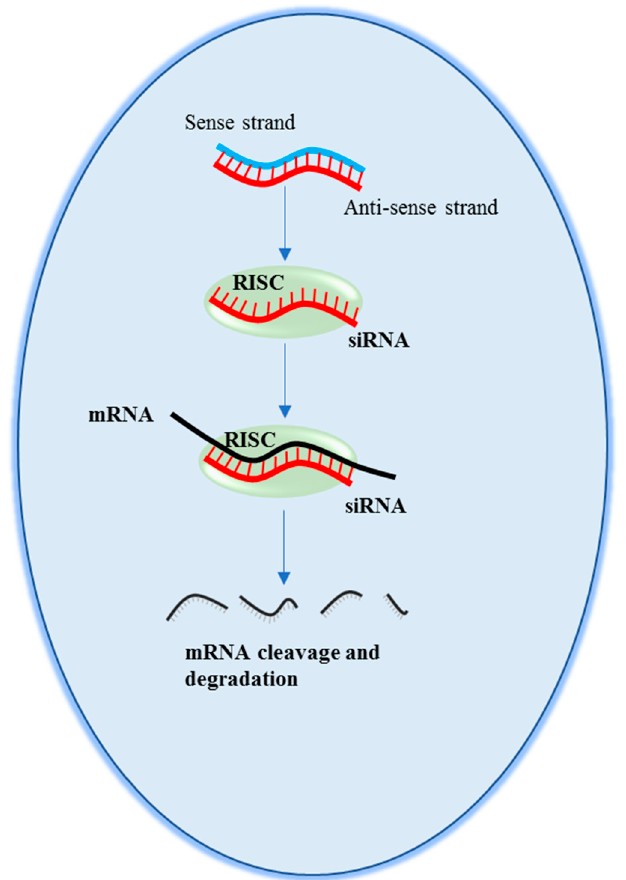
Figure 3. Short interfering RNA (siRNA) mechanism of action.